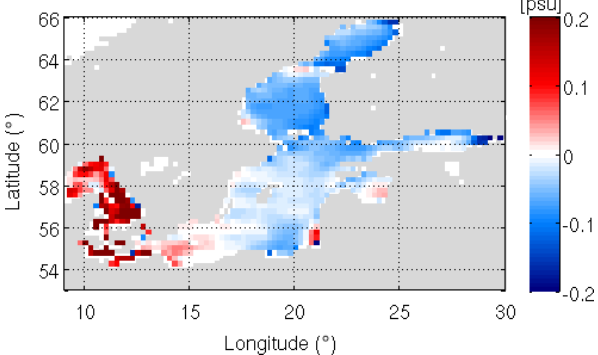
Figure 7. Mean error when applying a single annual reference cli- matology instead of a different climatology computed for each bin of